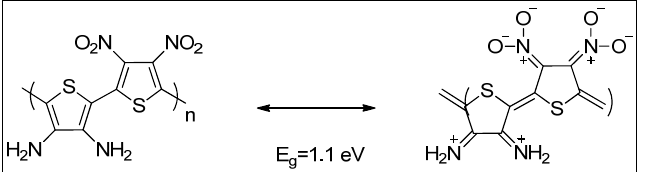
Figure 17. Incorporation of electron donor and acceptor on the thiophene molecules exhibits QD structures.